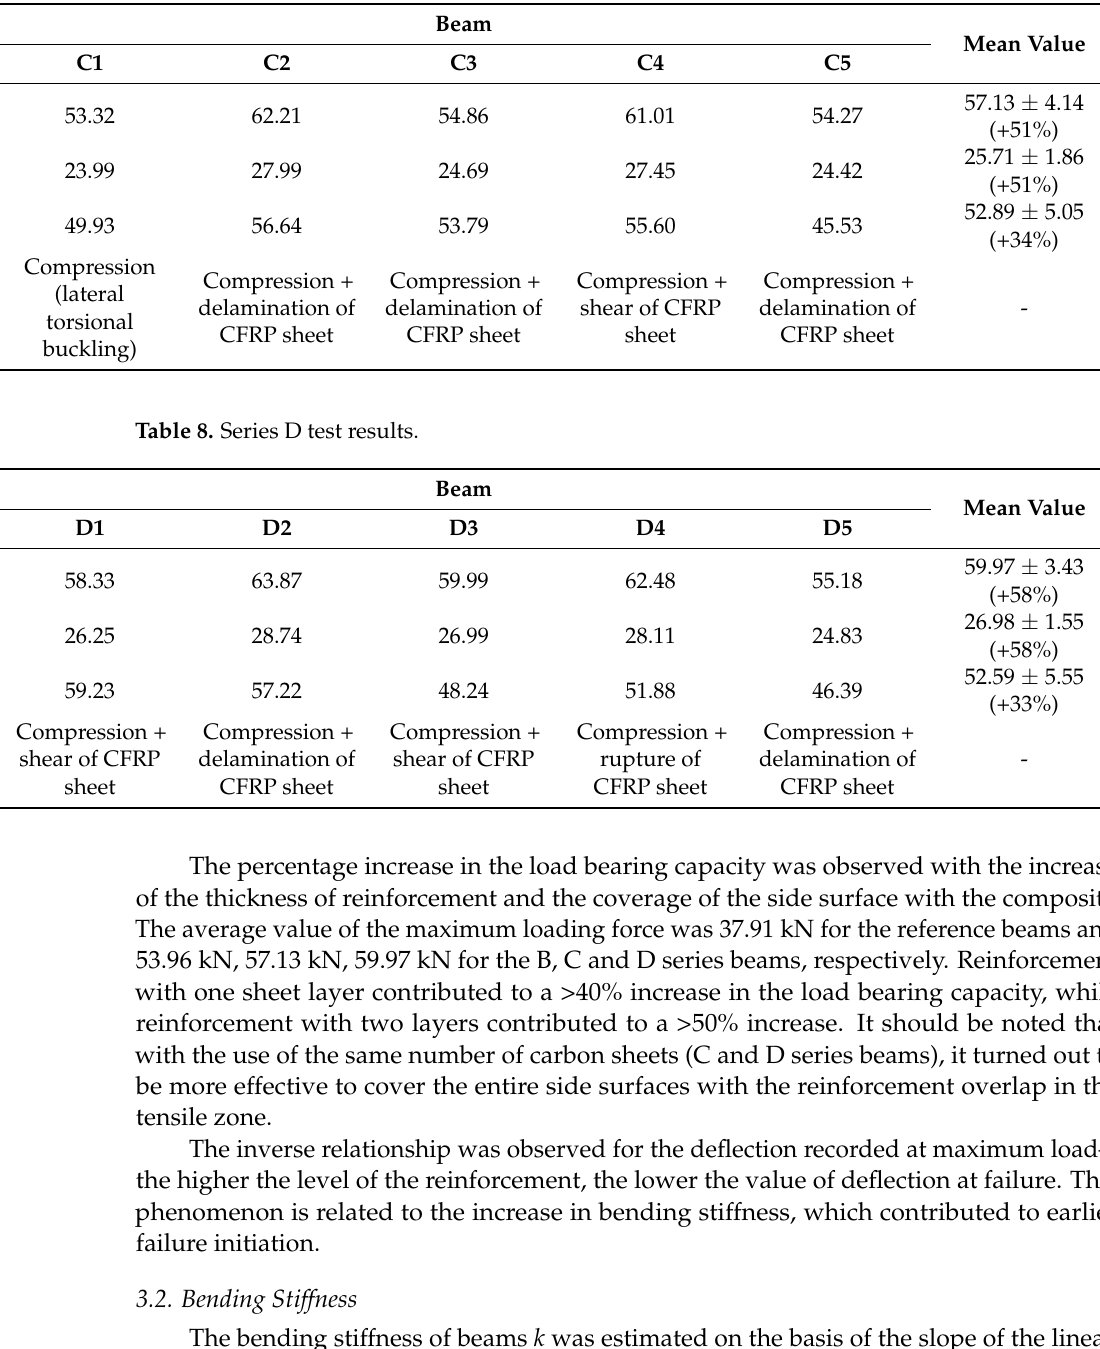
Table 7. Series C test results.